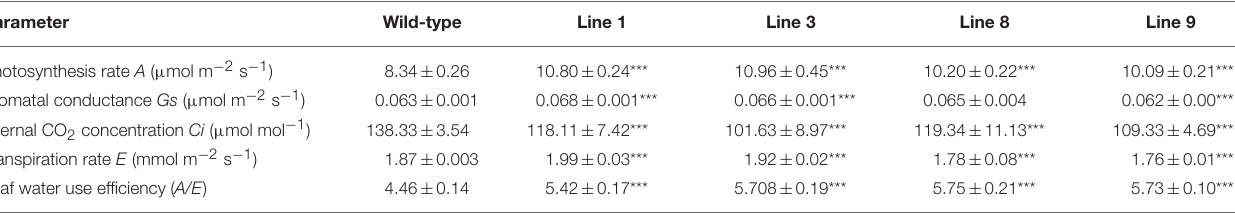
TABLE 1 | Analysis of the photosynthetic indexes in the wild-type and BpMYB106 overexpressing transgenic birch plants grown under normal conditions. Parameter